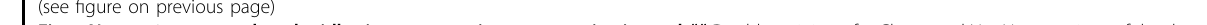
Despite the fact that all the studies mentioned above highlight the great value of in vivo reprogramming for disease modeling and cell therapy, the applications of reprogrammed neurons in other neuronal diseases or the basic integration of reprogrammed neurons into existing neural circuits are seldom characterized.